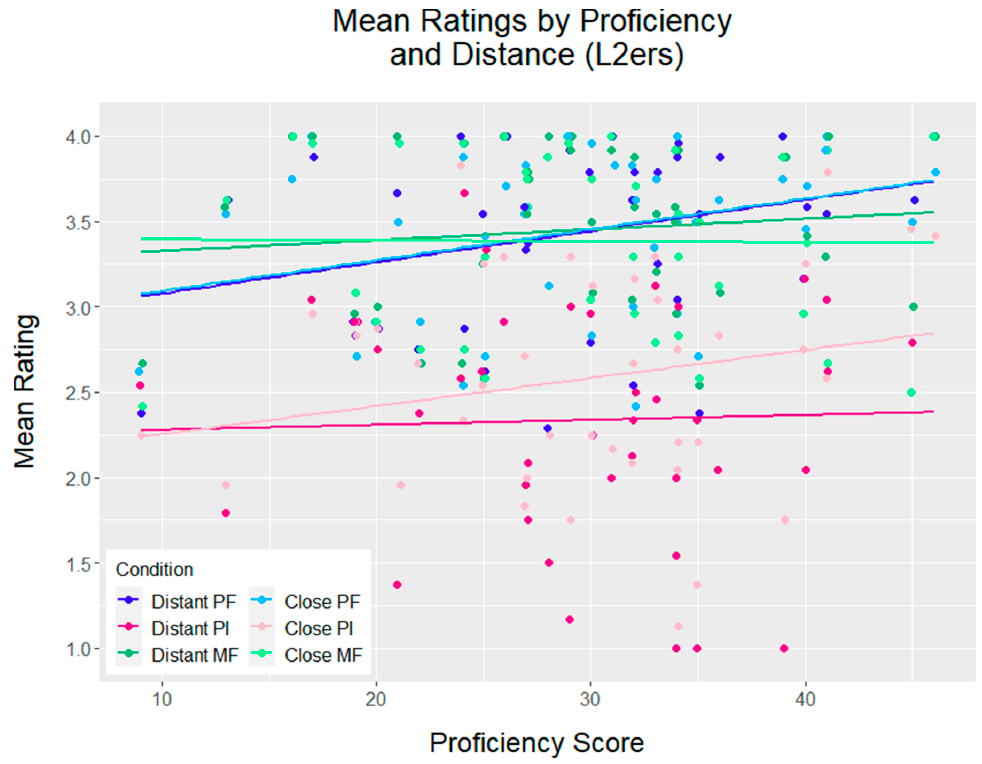
Figure 3. Proficiency and mean ratings by verb form and temporal distance.